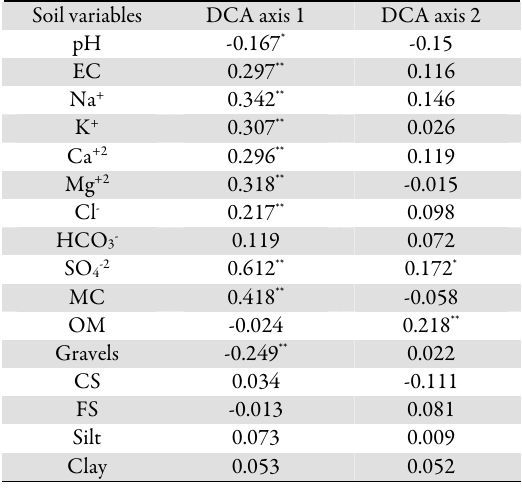
Tab. 5. Floristic diversity between the northern and southern parts of the Eastern Desert. ( 1 =Data from Abdel Aleem, 2013); T1N= Cairo- Suez transect; T2N= Korimat-Zaafarana transect, T3N= Sheikh Fadl-Ras Gharib transect; T1S= Qena-Safaga transect; T2S= Idfu-Marsa Alam transect; T3S= Aswan-Kharit-Gimal transect and T4S= Red Sea transect.